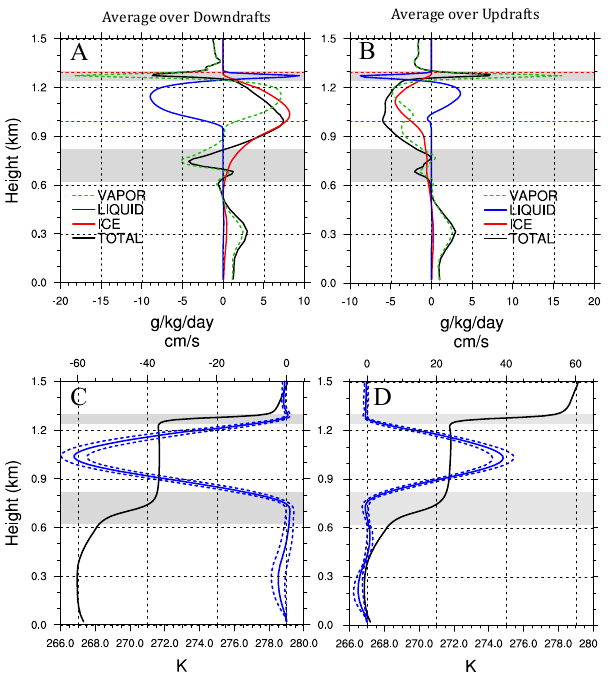
Fig. 16. Average profiles in downdrafts (left side; A , C ) and up- drafts (right side; B , D ) in the square box of liquid, vapor, ice and total water mixing ratio tendencies ( A , B ; gkg − 1 day − 1 ) and mean resolved vertical velocity (blue, ± one standard deviation of one- min averages dashed; cms − 1 ) and equivalent potential temperature (black; K) (C, D) . Entrainment zones indicated with gray shading. Cloud layer top and base indicated by red dashed lines in (A, B) . Fig. 17. Processes that contribute to water content tendencies be-